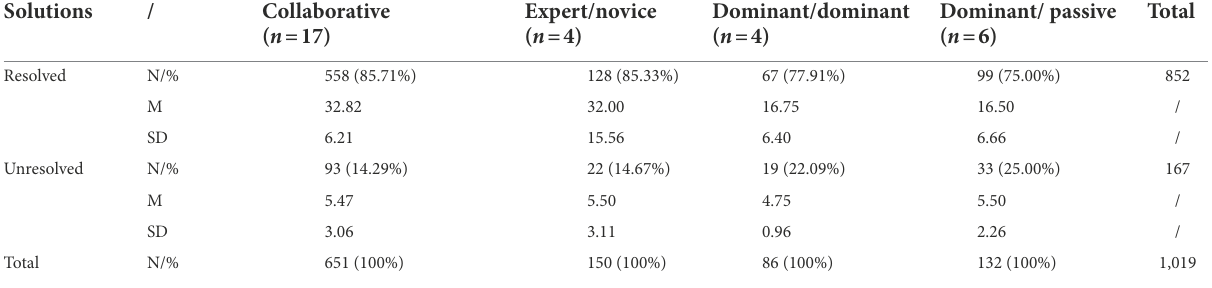
TABLE 3 Solutions of LREs by dyadic patterns.